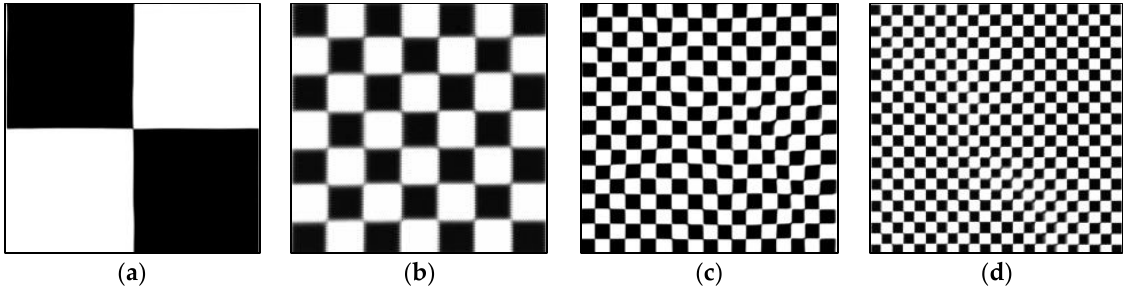
Figure 3. Target images under various numbers of measurement points affected by optical turbulence for a target side length of 285 pixels, Number of measurement points ( a ) 1, ( b ) 36, ( c ) 256, and ( d ) 484.